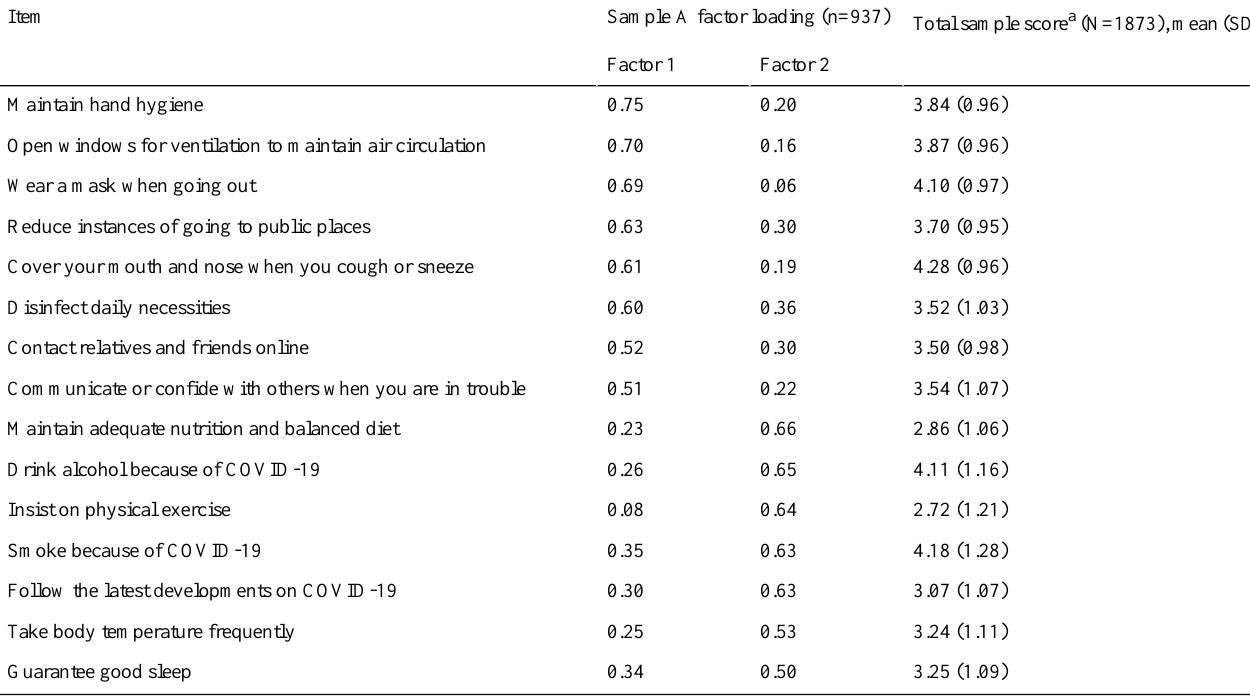
Table 2. Exploratory factor analysis and descriptive statistics of the COVID-19–related health behavior questionnaire for college